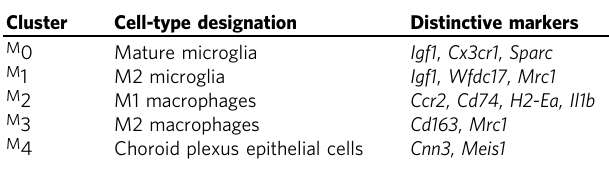
Table 2 Identi fi cation of clusters with myeloid characteristics ( M 0 – M